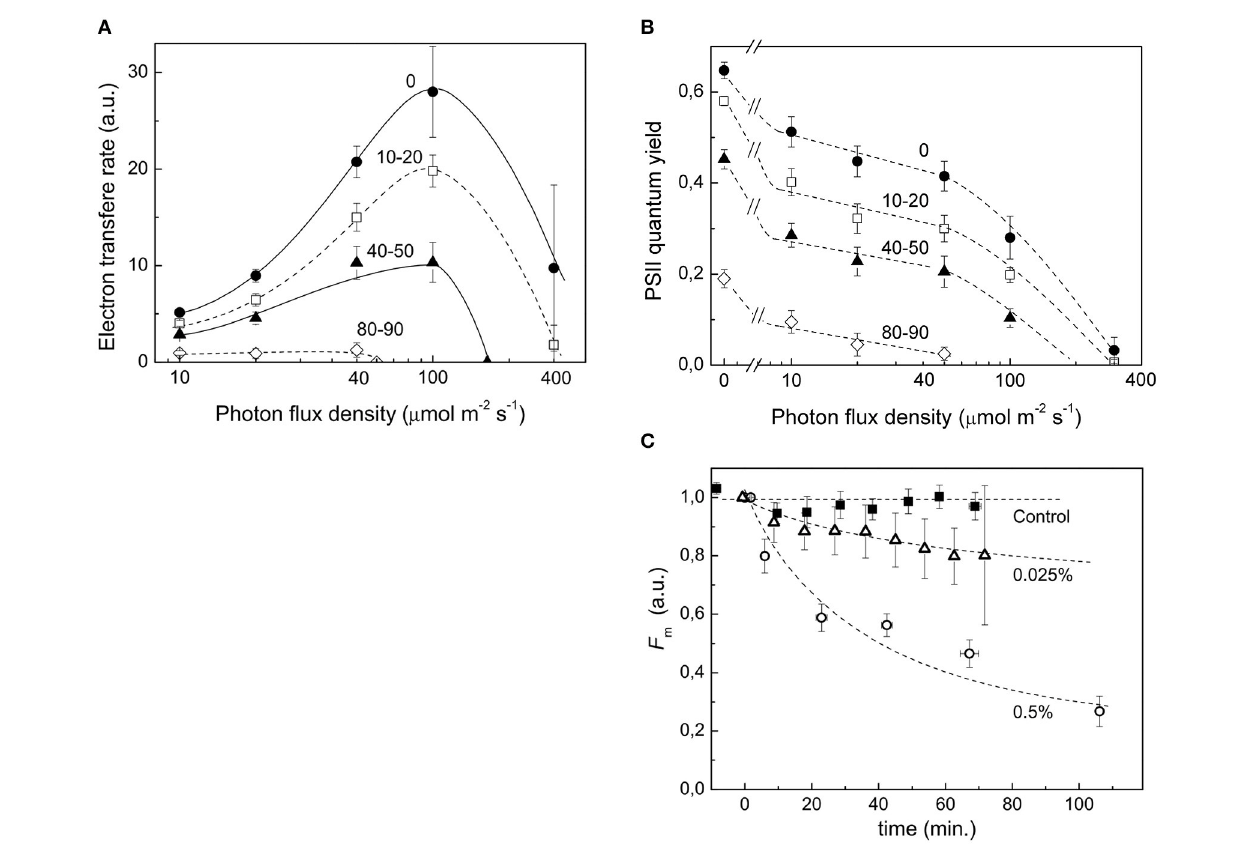
FIGURE 3 | Decrease in functional activity of chloroplasts during Driselase treatment. (A) Linear electron transport rates were calculated from PSII effective quantum yields at different actinic light intensities. The numbers near the curves represent the time (in minutes) of exposure of protonema to 0.5% (w/v) Driselase. The average values ± standard errors from 4 to 7 samples are presented. (B) Decrease in PSII effective quantum yields at different actinic light intensities. The numbers near the curves represent the time (in minutes) of exposure of protonema to 0.5% (w/v) Driselase. The average values ± standard errors from 4 to 7 samples are presented. (C) Fm values over time of P. patens protonema exposed to Driselase. The numbers near curves indicate concentration of Driselase (w/v), “control” indicated protonema incubated in 0.48 M mannitol. The average values ± standard errors from 6 to 14 samples are